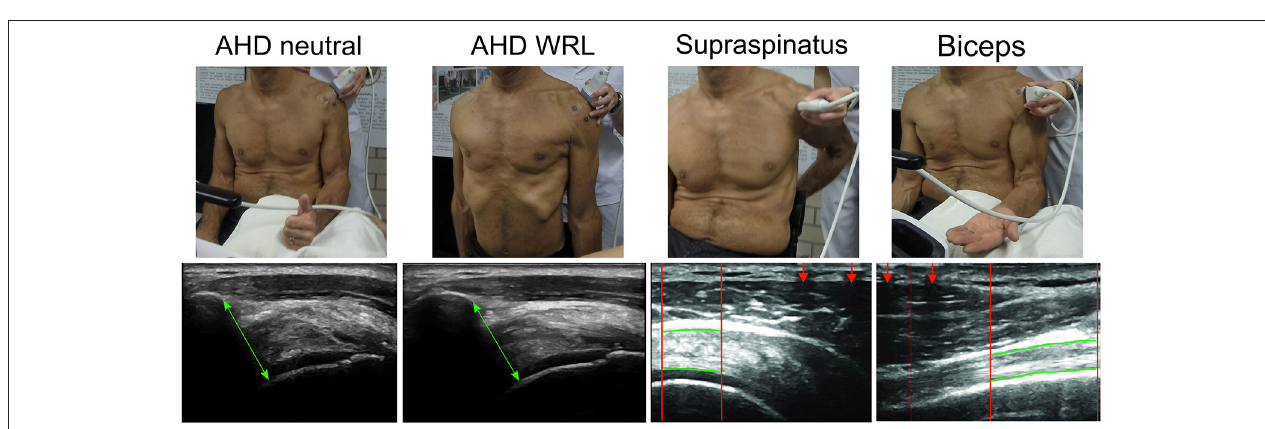
FIGURE 2 | Ultrasound measurements: position and example of measurement. Each type of measurements represents a different example participant and does not relate to the person of the position images. AHD neutral: acromiohumeral distance images in the neutral position were taken in a seated position with 90 ◦ elbow flexion with the thumb facing upward. AHD WRL: acromiohumeral distance images during WRL. Supraspinatus: transverse ultrasound images of supraspinatus tendon were taken in a seated position with the palm placed on the lower back, shoulder extended, and the elbow flexed posteriorly. Biceps: longitudinal images of long head of biceps brachii tendon were taken in a seated position with 90 ◦ elbow flexion and the hand palm facing upward. The region of interest (ROI) is presented between the red vertical lines with the upper border and lower border of the tendons marked with the manually identified red horizontal lines. Lines are marked thicker as compared with the actual analysis for visualization reasons. ROI is selected based on the interference pattern that resulted from a metal marker taped to the skin (assigned with red